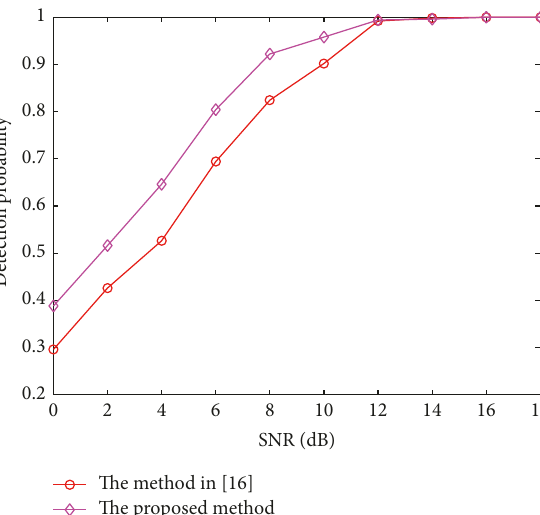
Figure 6: RMSE of DOA estimation with respect to the number of snapshots.